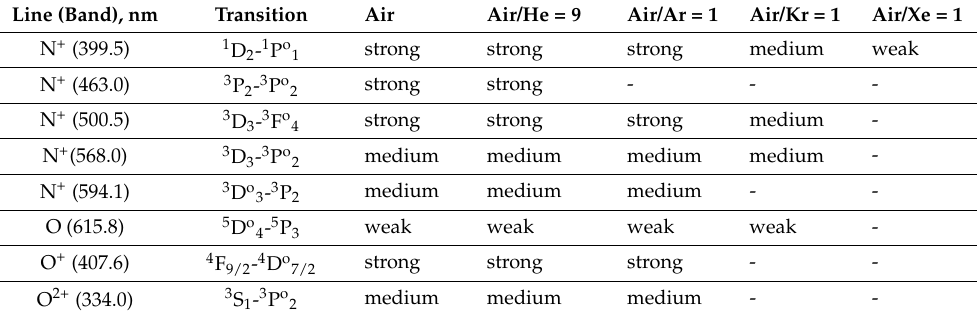
Table 3. Comparative intensities of the lines of excited air particles.